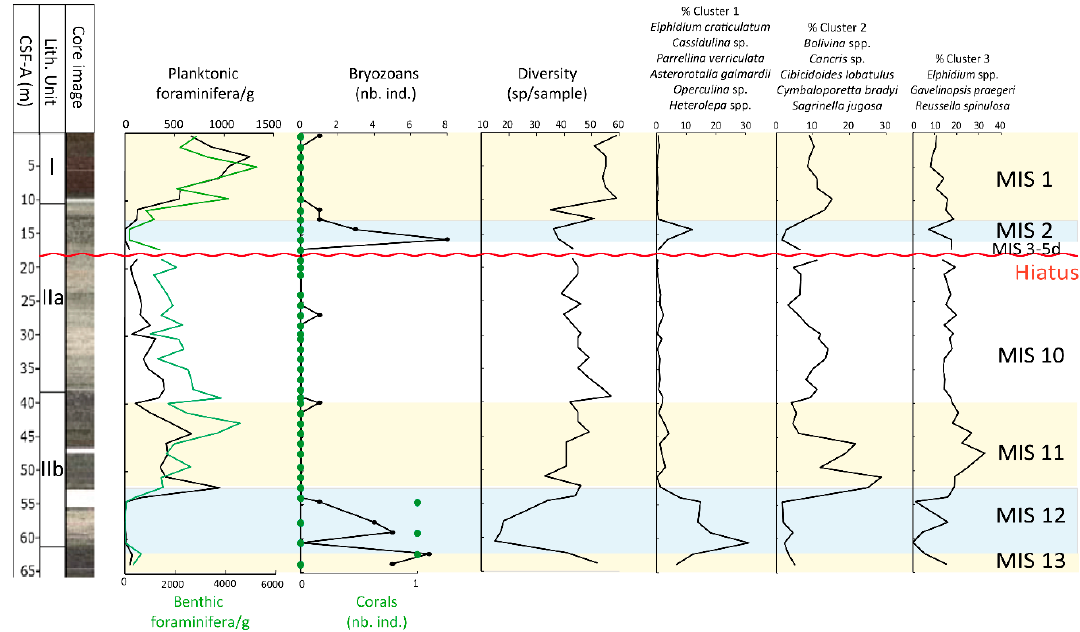
Figure 3. Lithostratigraphic units at Hole U1461A and micro-faunal abundance. The abundance of planktonic and benthic foraminifera (per gram), the number of bryozoans and corals, and the diversity for the benthonic foraminifera (number of species per sample) are presented in this figure. Only the clusters used for the bathymetric level identification are displayed here.